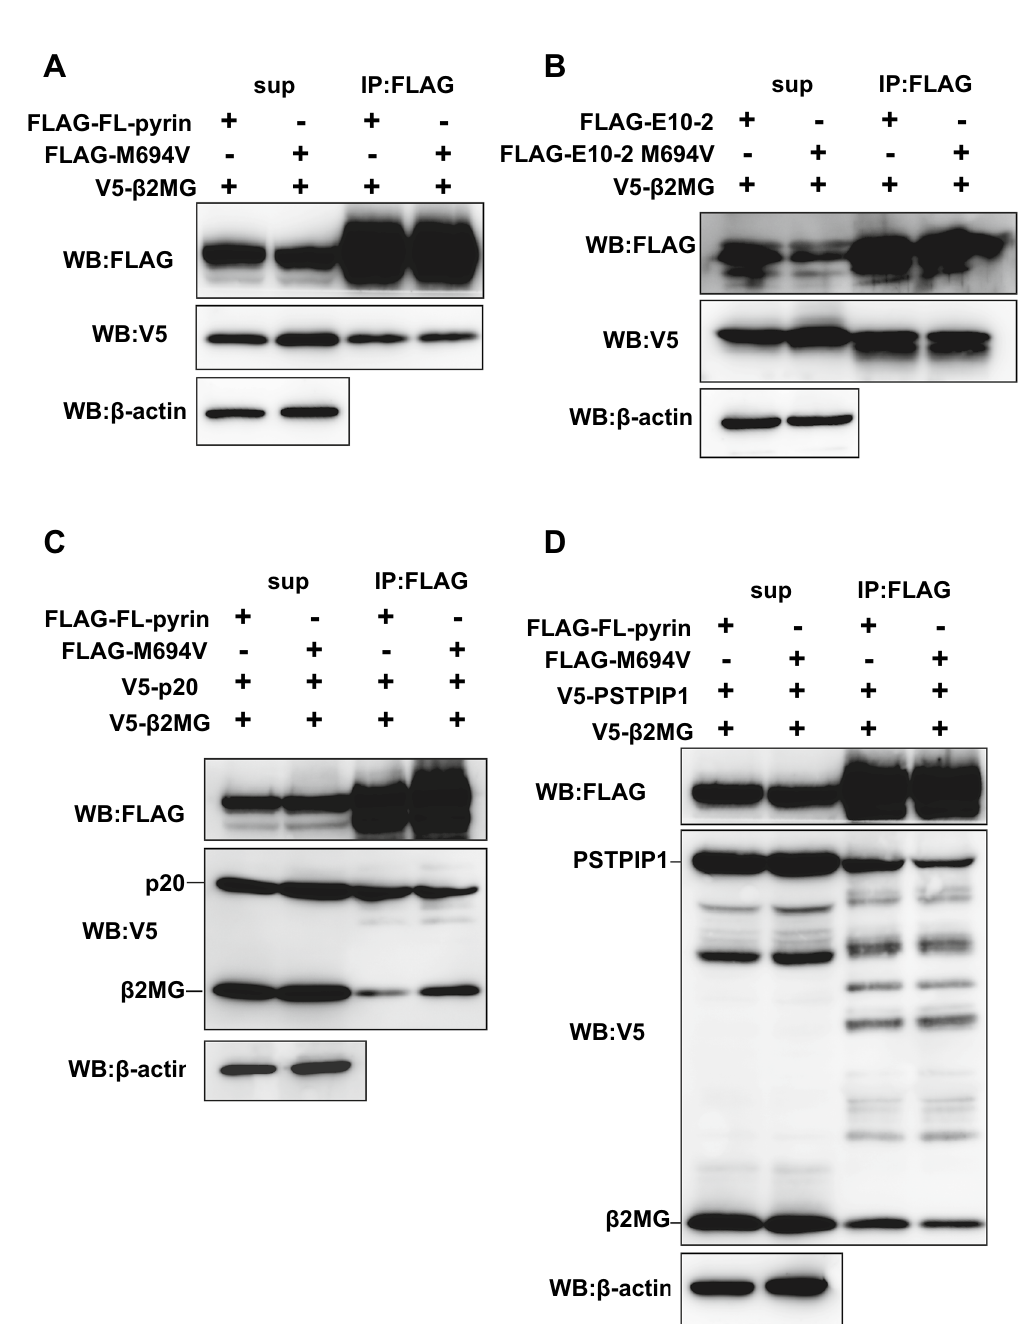
Figure 7. M694V mutation of pyrin weakens the competitive binding of p20 and promotes the recruitment of PSTPIP1 in the presence of β2MG. ( A ) Lenti-X 293T cells expressing FLAG-tagged full-length (FL) pyrin or M694V pyrin with V5-β2MG were lysed with lysis buffer and subjected to co-immunoprecipitation analysis using FLAG Ab-conjugated agarose. M694V mutation does not affect pyrin–β2MG affinity. ( B ) Lenti-X 293T cells expressing FLAG-tagged pyrin deletion mutant E10-2 or M694V-mutated E10-2 with V5-β2MG were lysed with lysis buffer and subjected to co-immunoprecipitation analysis by FLAG Ab-conjugated agarose beads. M694V mutation does not affect the affinity of E10-2 for β2MG. ( C ) Lenti-X 293T cells expressing FLAG- tagged FL- or M694V pyrin and V5-β2MG with or without V5-p20 were lysed with lysis buffer and subjected to co-immunoprecipitation analysis using FLAG Ab-conjugated agarose. Co-immunoprecipitation analysis reveals that M694V pyrin is prone to bind β2MG in spite of the presence of p20 (see also Supplementary Fig. S1B). ( D ) Lenti-X 293T cells expressing FLAG-tagged FL- or M694V pyrin with V5-PSTPIP1 and V5-β2MG were lysed with lysis buffer and subjected to co-immunoprecipitation analysis using FLAG Ab-conjugated agarose beads. Co-immunoprecipitation analysis shows no difference in the recruitment of PSTPIP1 between the wild type and M694V pyrin (see also Supplementary Fig.